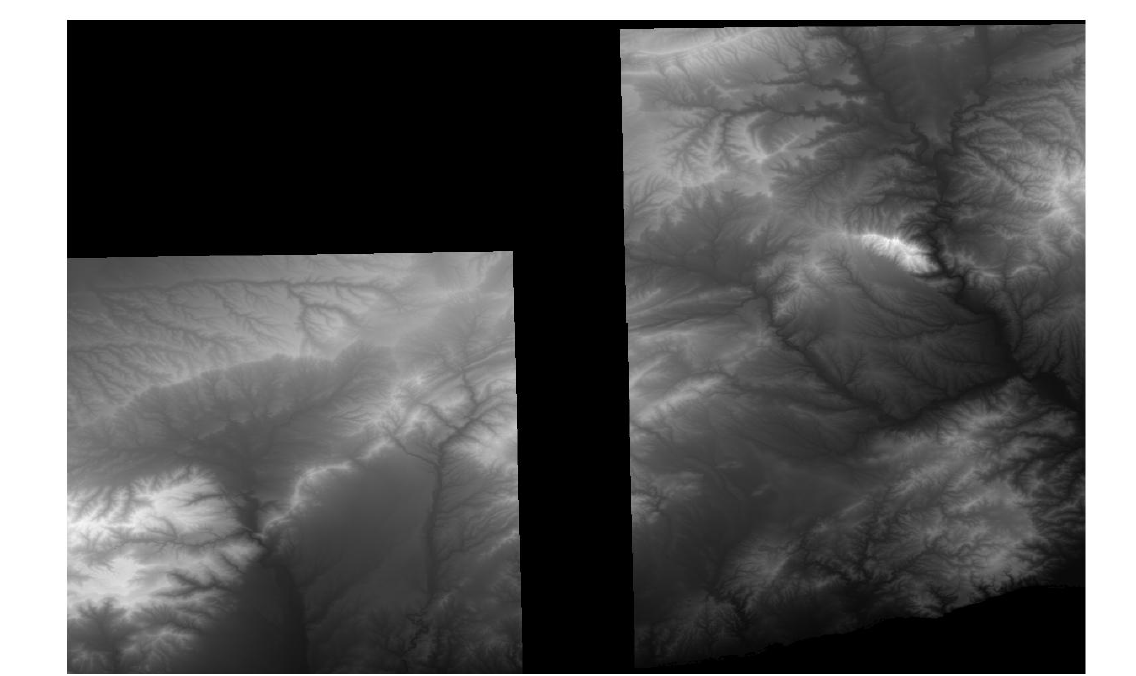
Figure 16. ICC Ground truth DEM.